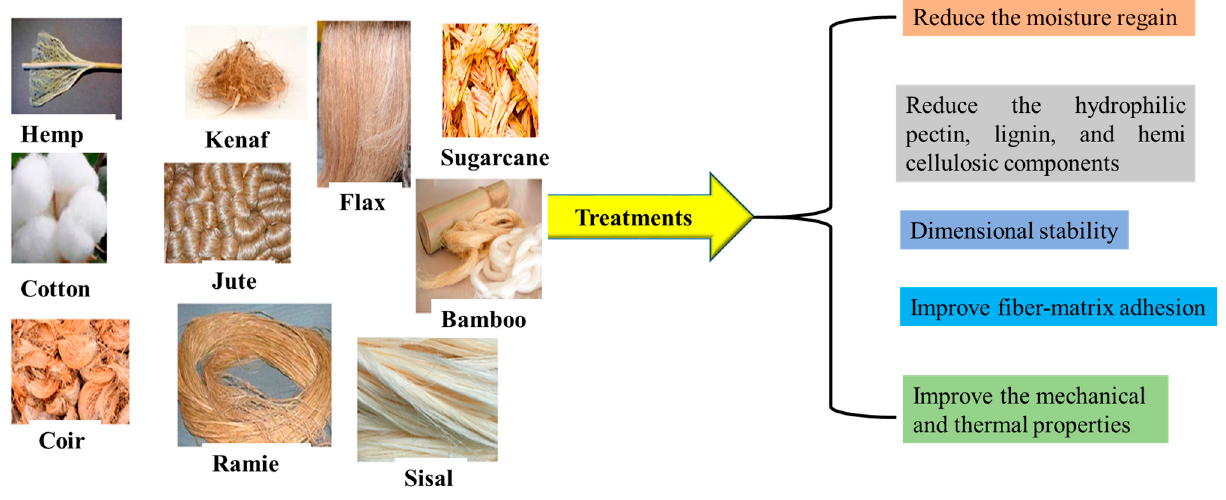
Figure 4. Results of fiber treatments [140]. Reprinted with permission. Copyright 2020 MDPI.